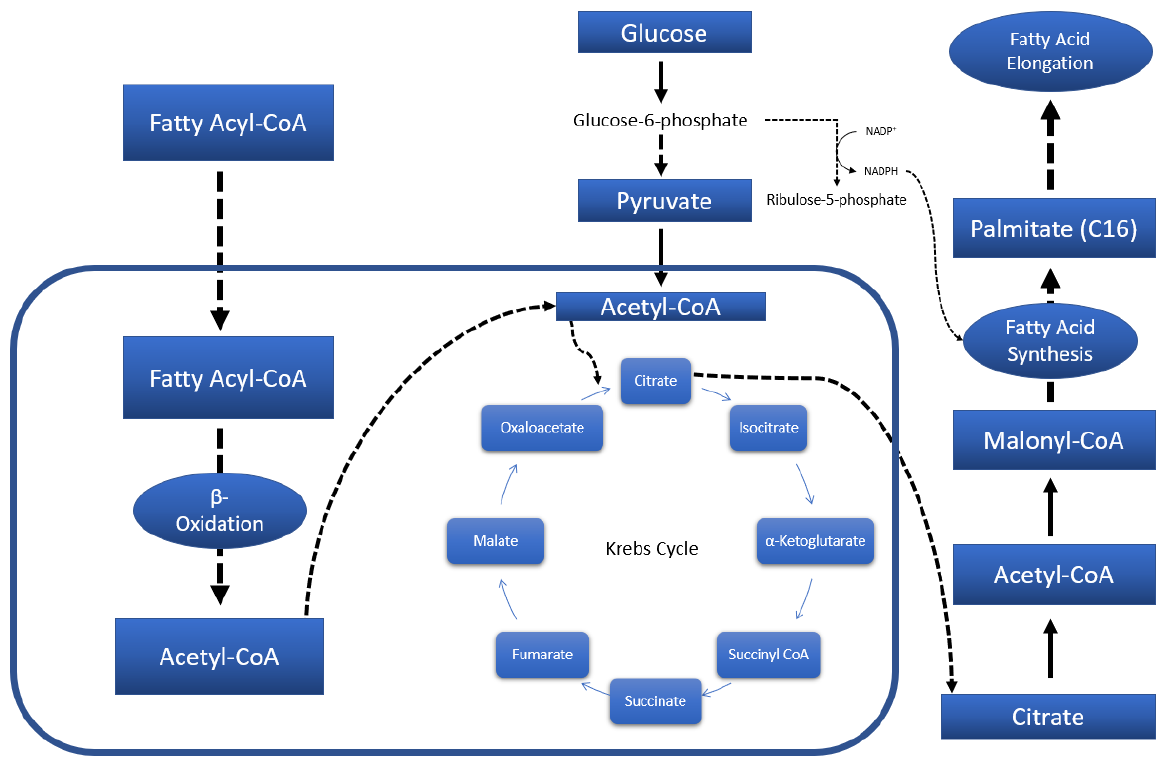
Figure 4. Brief representation of the main fatty acid metabolic pathways.